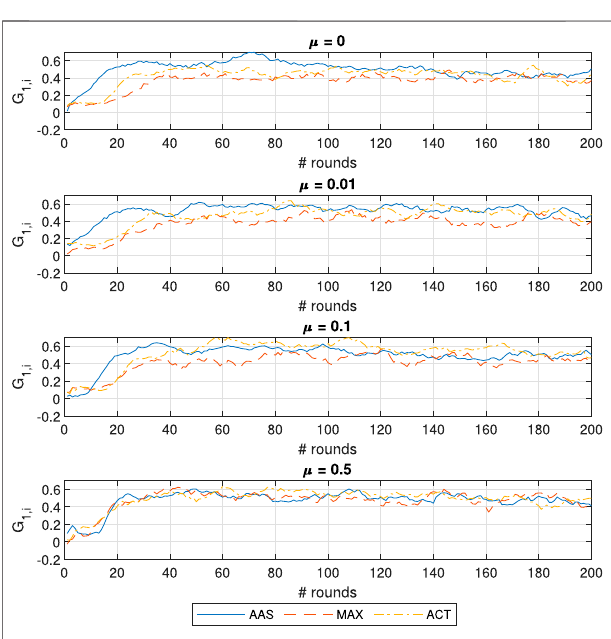
FIGURE 5 | Contribution evolution for learner k (cid:2) 1 in the case of using the MNIST dataset.